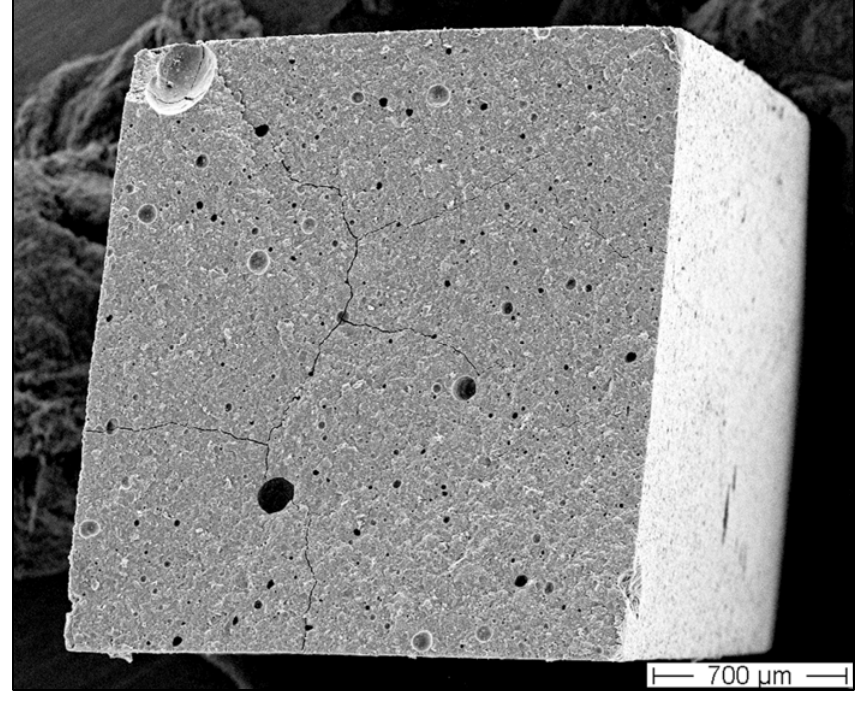
Figure 5. Typical pore size distribution in a commercial encapsulated